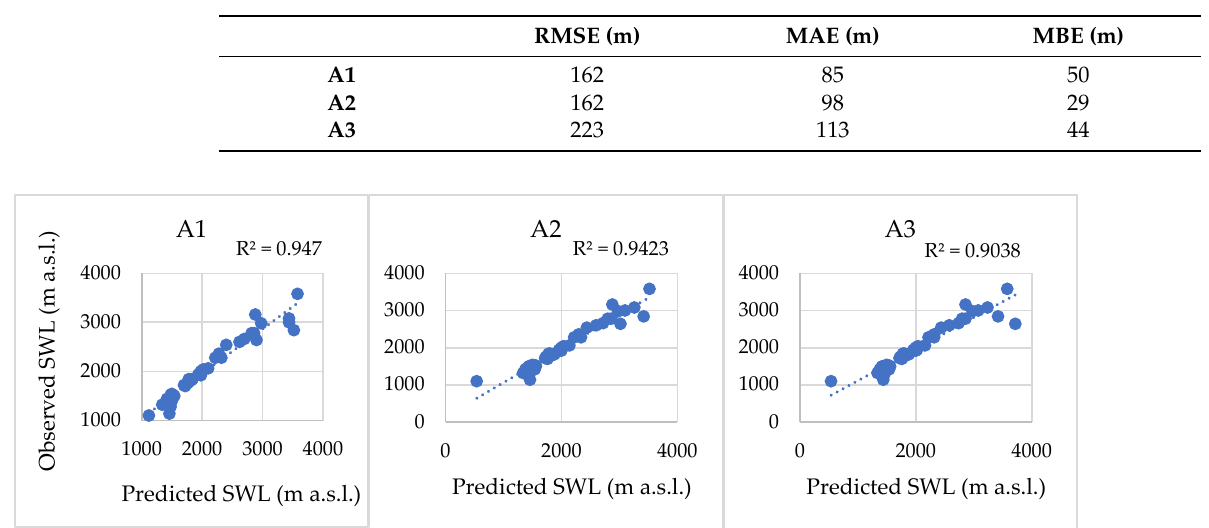
Table 4 . Root Mean Squared Error (RMSE), Mean Absolute Error (MAE), and Mean Bias Error (MBE) of the predicted snowline elevation.